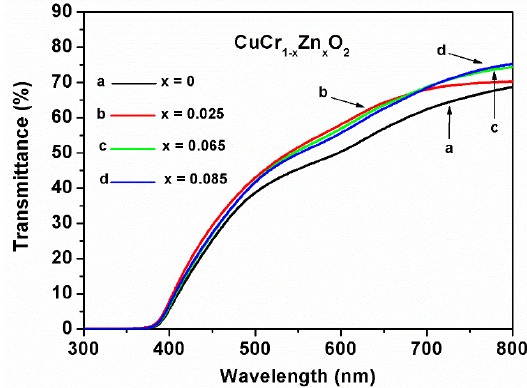
Figure 5. Transmittances of the CuCr 1 − x Zn x O 2 thin films.